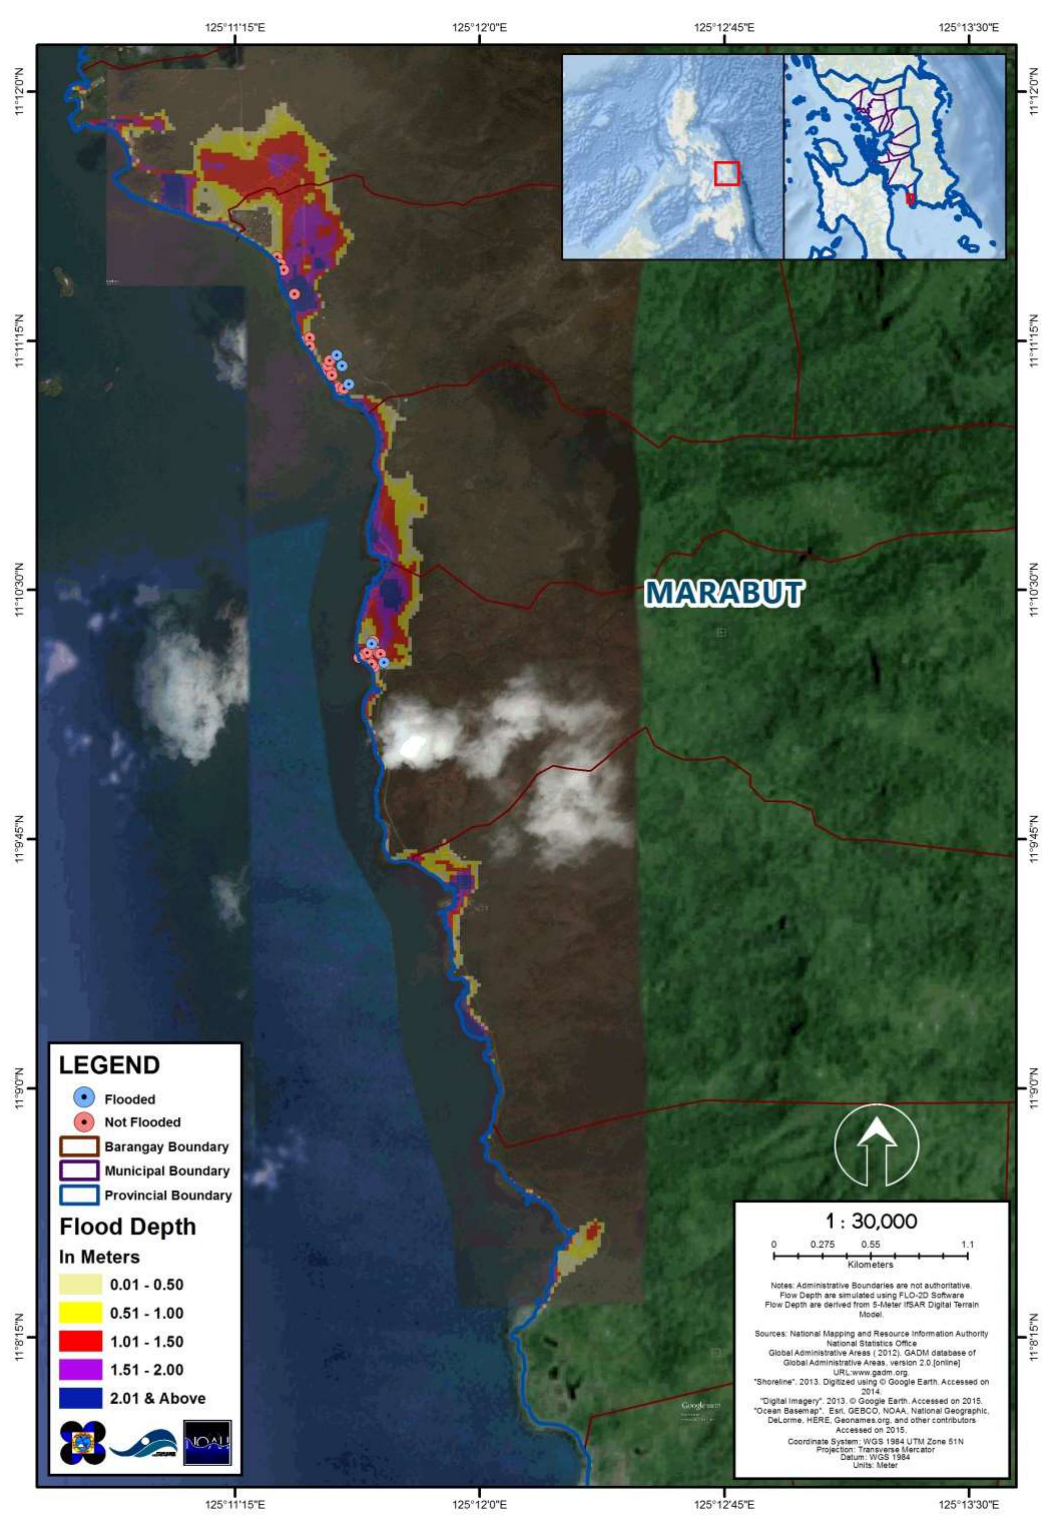
Figure 7. Storm surge inundation and validation points of Marabut, Samar. Validation points: blue circle (observed flooding) and red circle (no flooding).